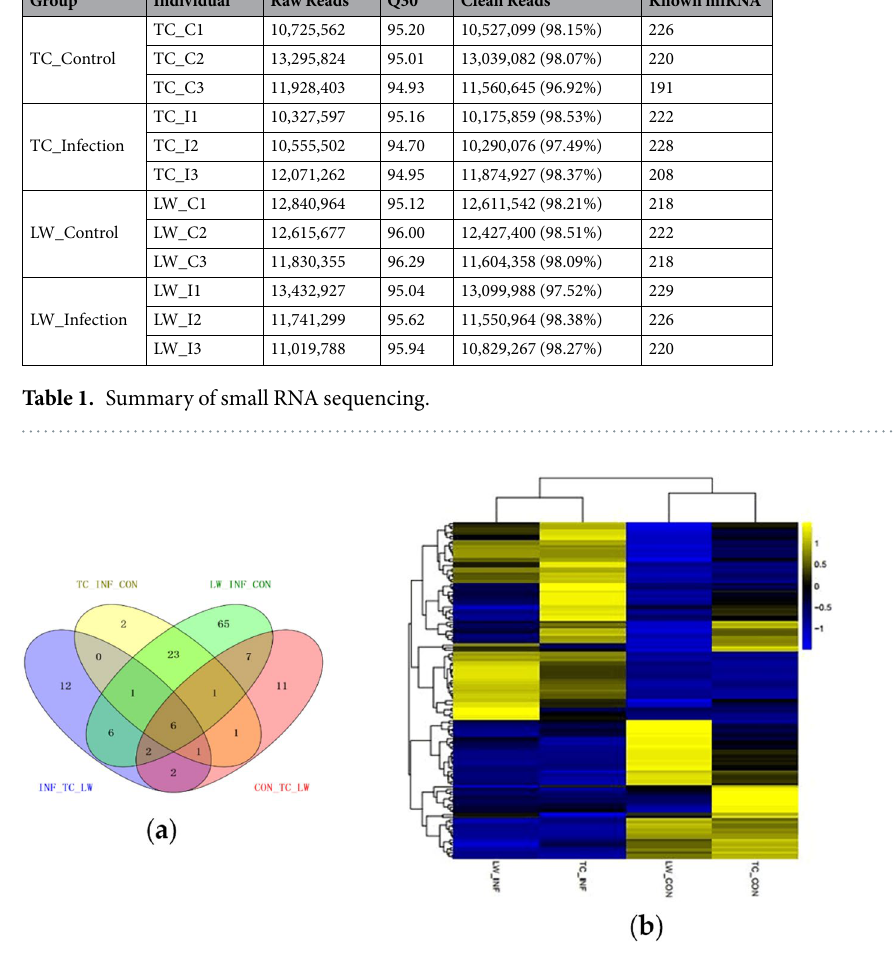
Figure 1. Analysis of DEmiRNAs. ( a ) Venn diagram for the distribution of DEmiRNAs in the four comparisons. ( b ) Heatmap showing the expression level for DEmiRNAs. MicroRNAs shown in yellow means higher expression and blue means lower expression.